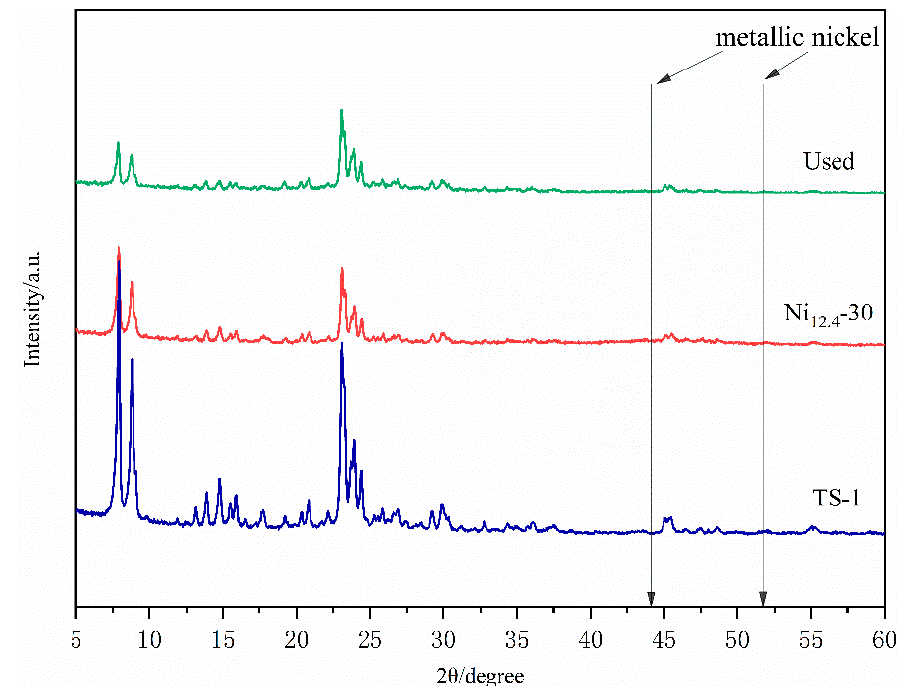
Figure 1. XRD pattern of heterogeneous catalyst Ni 12.4 -30. In order to further identify the chemical state of the catalyst, Ni 12.4 -30 (both the fresh and the recycled ones) were subjected to XPS analysis, and the results are shown in Figure 2. The signals of high-resolution XPS spectra that emerged at around 860 and 190 eV correspond to Ni and B, respectively [80]. The peaks at 853 and 856 eV in Ni 2p 3/2 are ascribed to the metallic nickel and oxidized nickel. The XPS spectrum of pure nickel boride alloy has only one peak of Ni(0), while the peak of Ni(II) appears when nickel boride is supported, in line with previous reports [69–71,81]. The peaks at 188 and 192 eV in B 1s are assigned to elemental and oxidized boron, respectively. The peaks of pure boron in B 1s at 187 eV (< 188 eV) may result from Ni-B interaction. No significant difference in chemical states of Ni and B appears in the used catalyst, indicative of the catalyst’s high